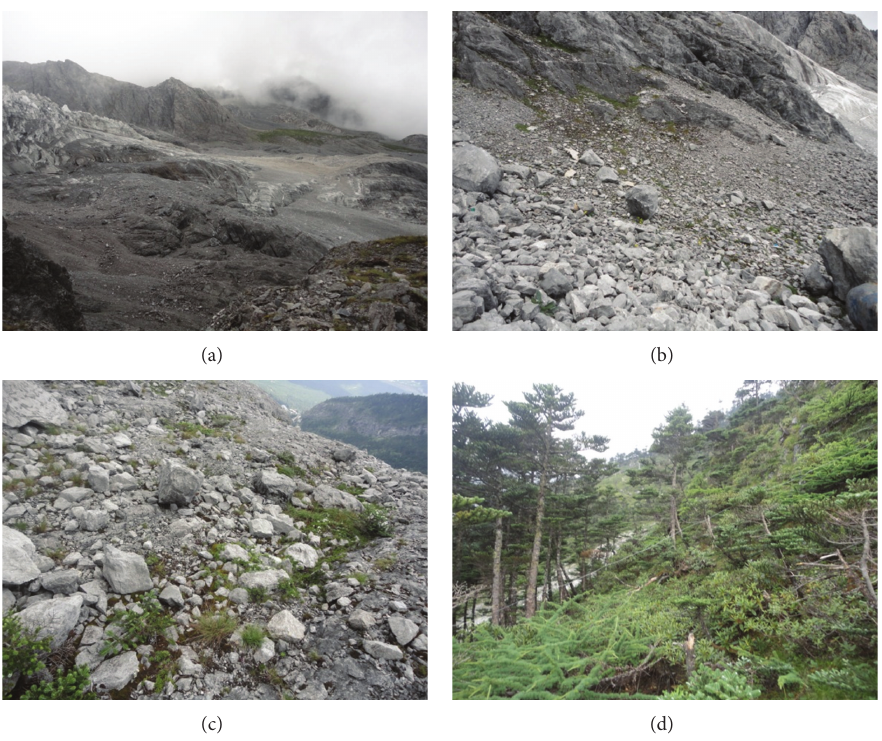
Figure 5: Photos showing the bare land (a), earliest succession stage (b), middle succession stage (c), and last succession stage (d) on the foreland of